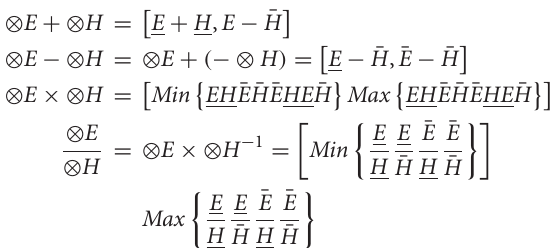
Stage 4: In the fourth stage, constructing the grey decision